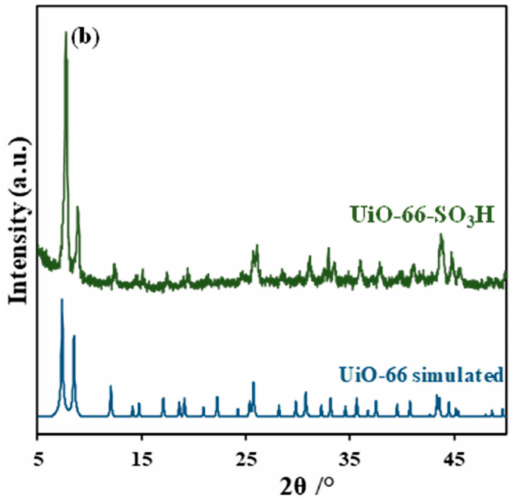
Figure 1. XRD patterns of ( a ): Hopcalite and CeO 2 -NR, ( b ): UiO-66-SO 3 H.